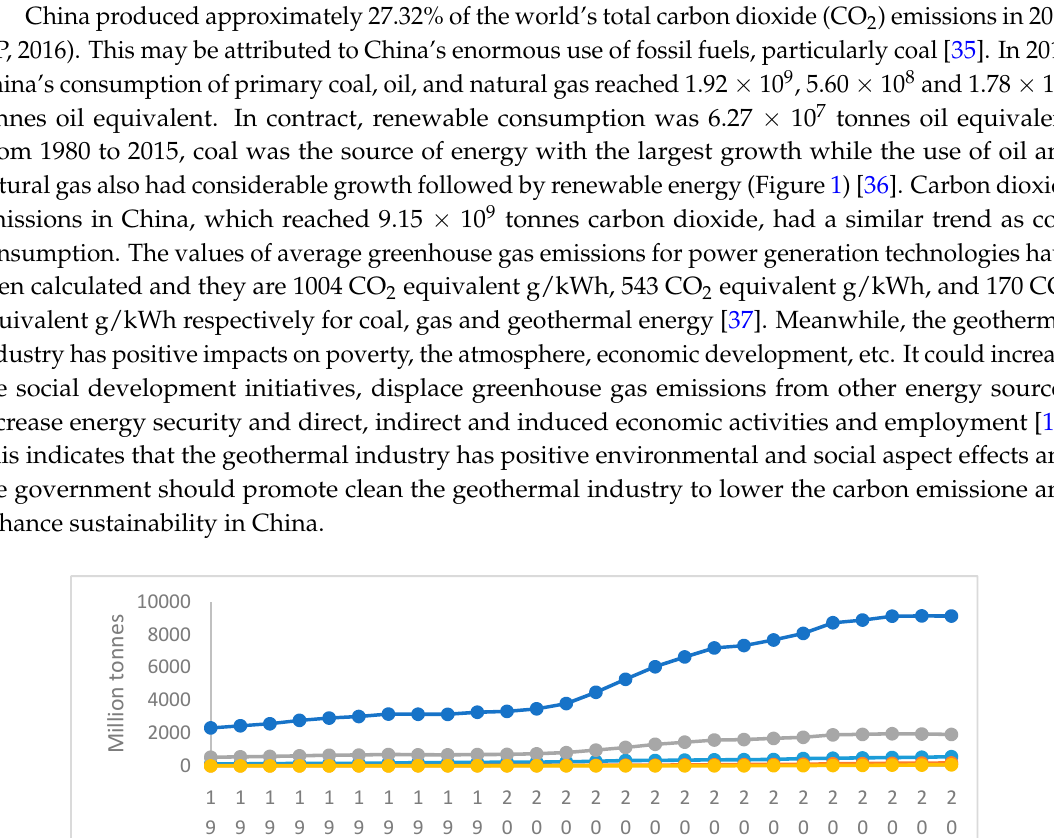
Table 3. Strategic targets of geothermal energy development in China [3,32].